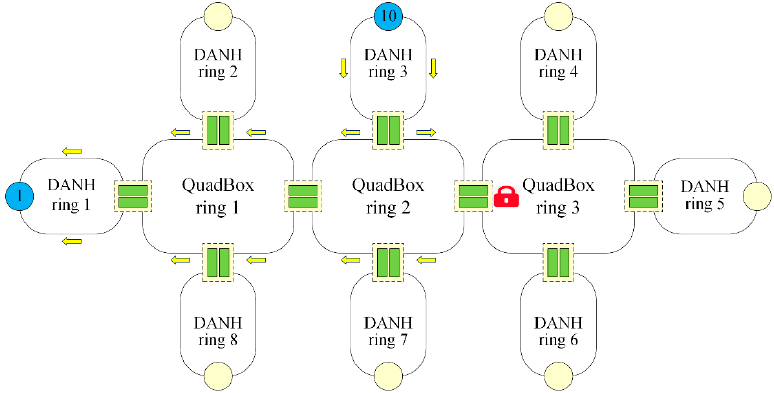
Figure 3. Using the locking message to discover passive QuadBox rings in EFA.